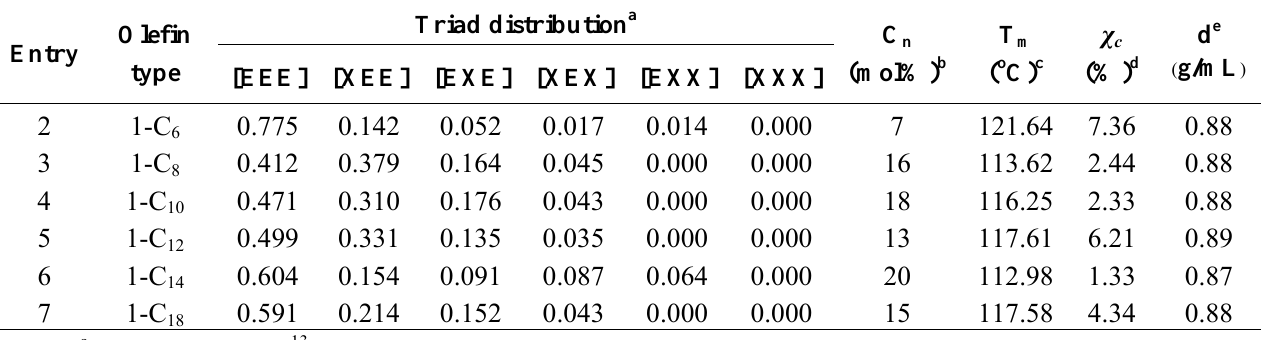
Table 3. Triad distribution and properties of the resulting ethylene/1-olefin